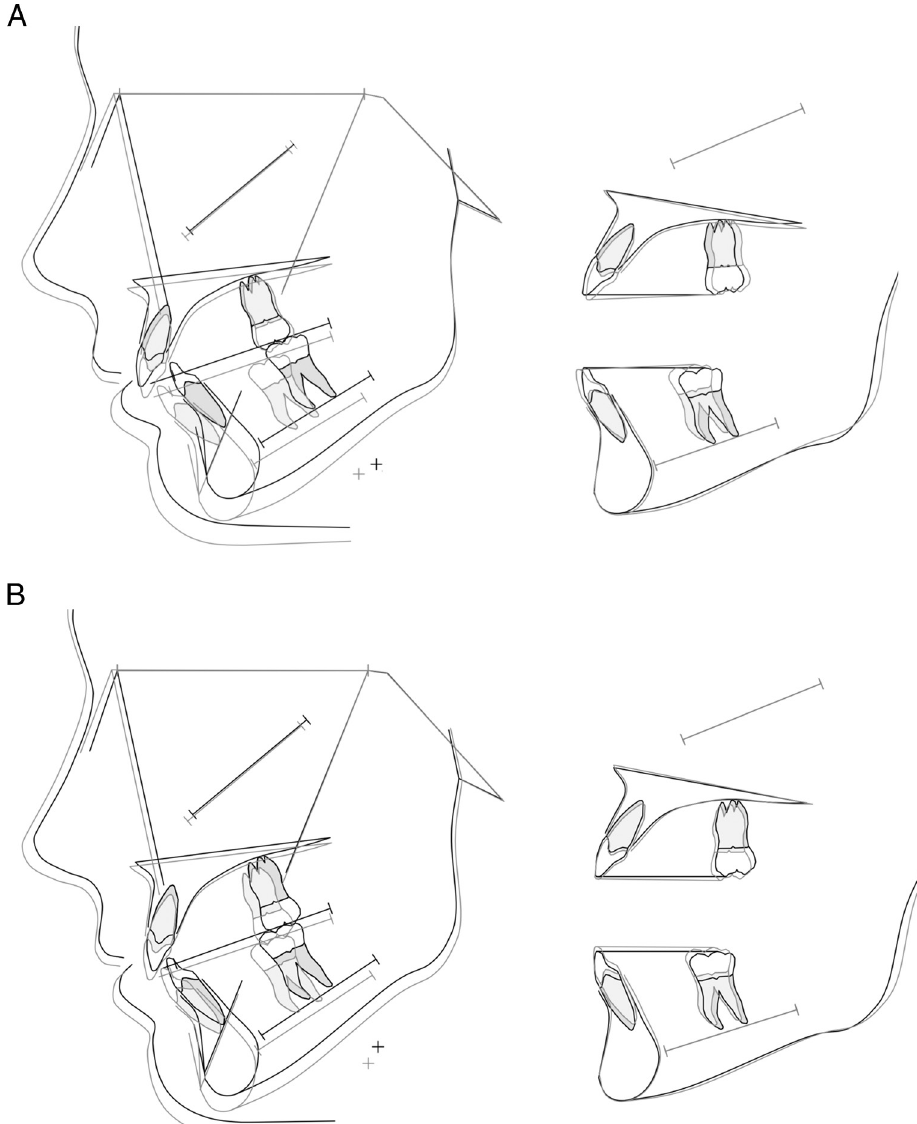
Figure 2. Mean cephalometric changes in (A) the FA and (B) control groups using the structural method (+ denotes hyoid